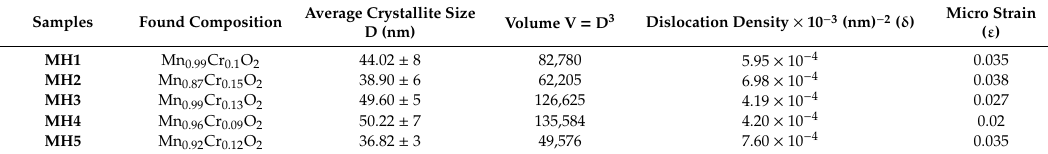
Table 2. Synthetic conditions, composition and PXRD parameters of nanomaterials (MH1–MH6).